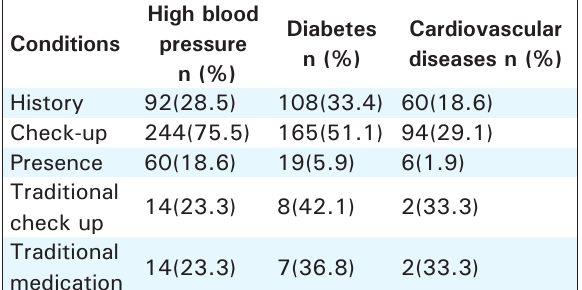
Table 7. NCDs condition and care seeking among government